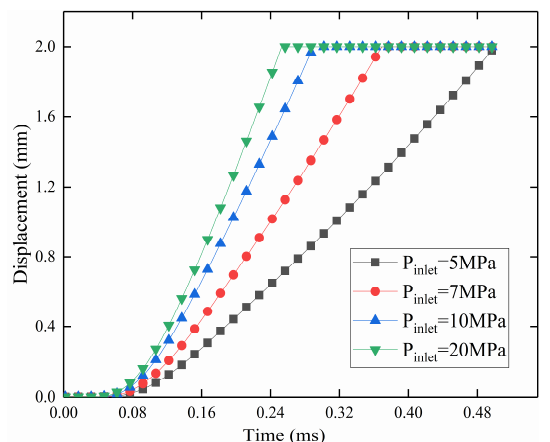
Figure 16. Displacement of valve spool for different driving pressures.